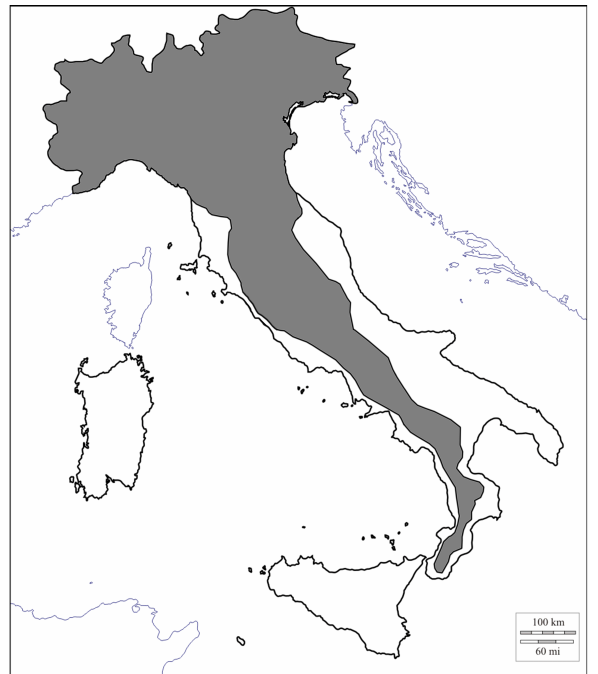
Figure 10. Distribution map of Sorex antinorii (redrawn from Aloise and Nappi 2008).